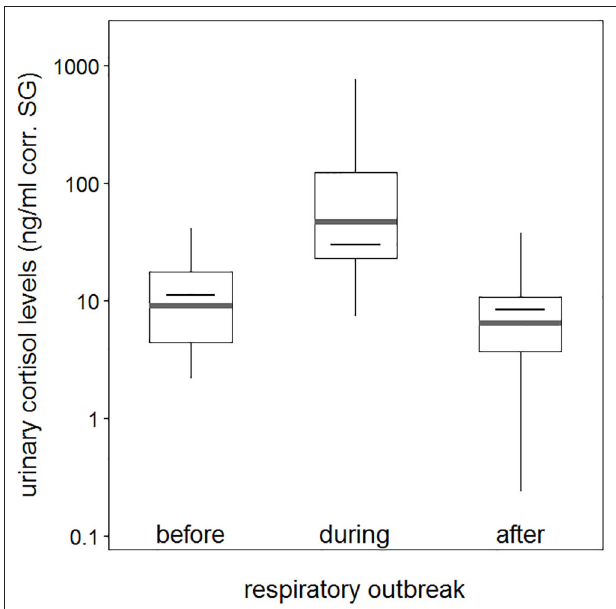
FIGURE 1 | Urinary cortisol levels about sample periods (before, during, and after a respiratory outbreak). Indicated are the median (gray bar) and the fitted model and its 95% confidence intervals (black bar and error bars). Boxes indicate quartiles (25 and 75%), and vertical lines represent quantiles (2.5 and 97.5%). The y-axis is log-transformed.